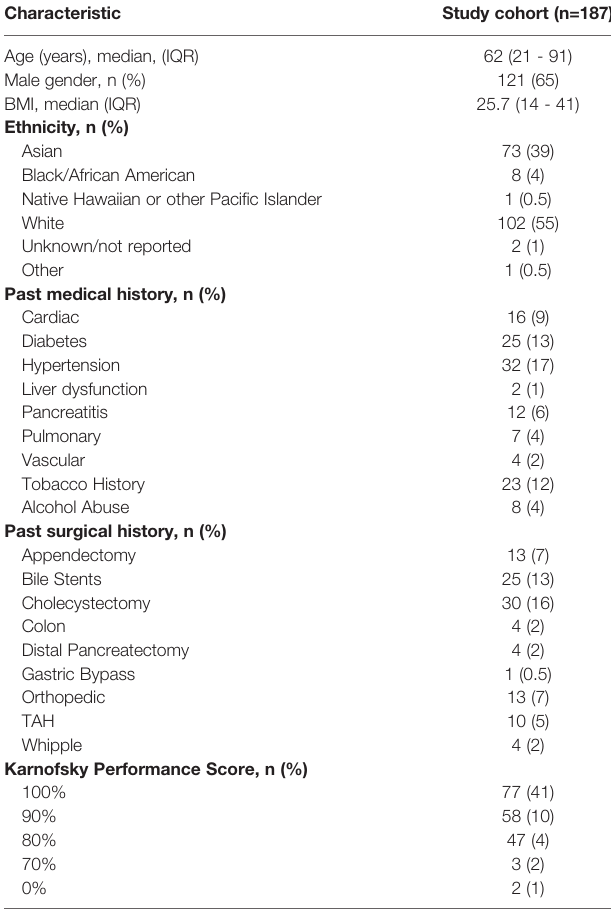
TABLE 1 | Patient characteristics at baseline of entire